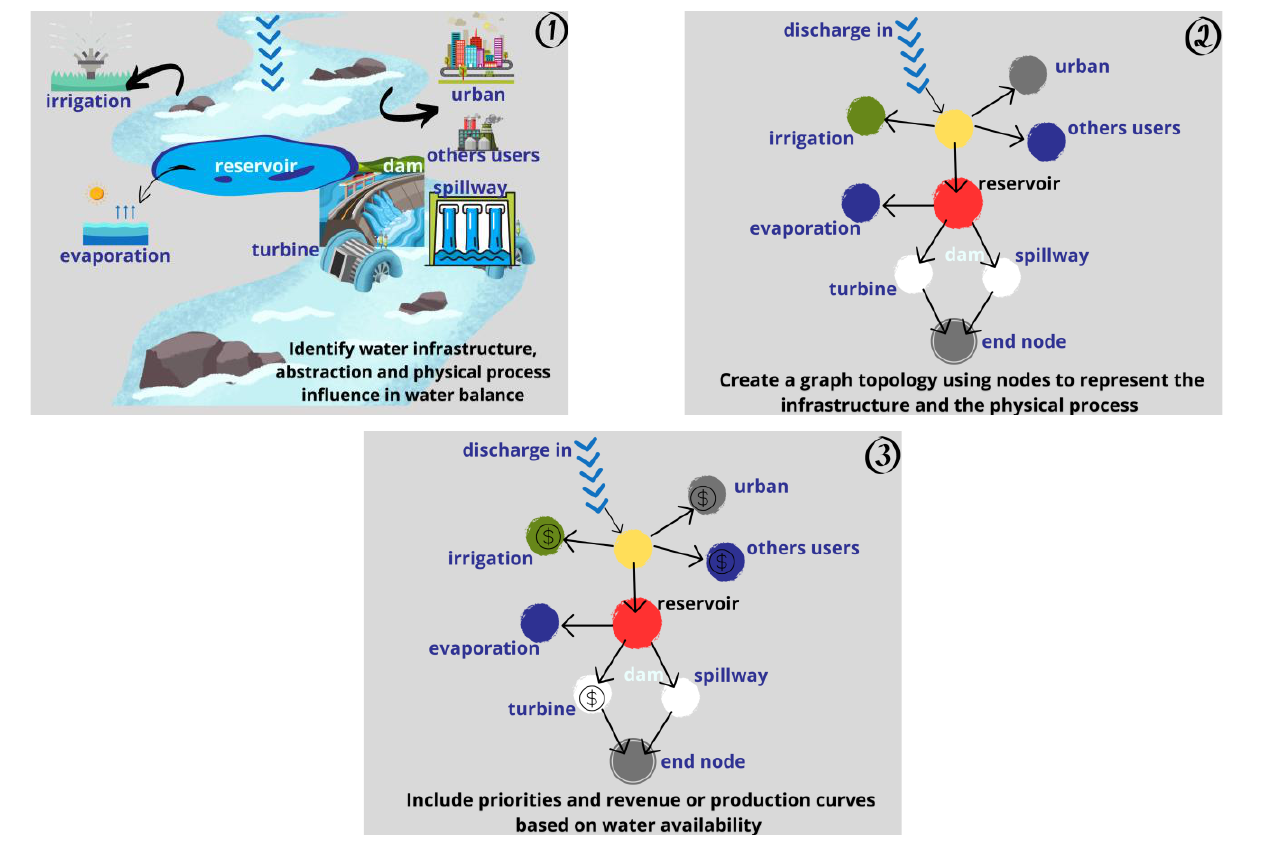
Figure 1. Topological representation of the water infrastructure in a river system as a graph. Figure step 1 represents the process of identifying water infrastructure, abstraction, and physical processes that influence water balance. Step 2 represents the creation of a graph topology using nodes to represent the elements identified in Step 1 . Step 3 includes priorities and revenue, or production curves based on water availability.